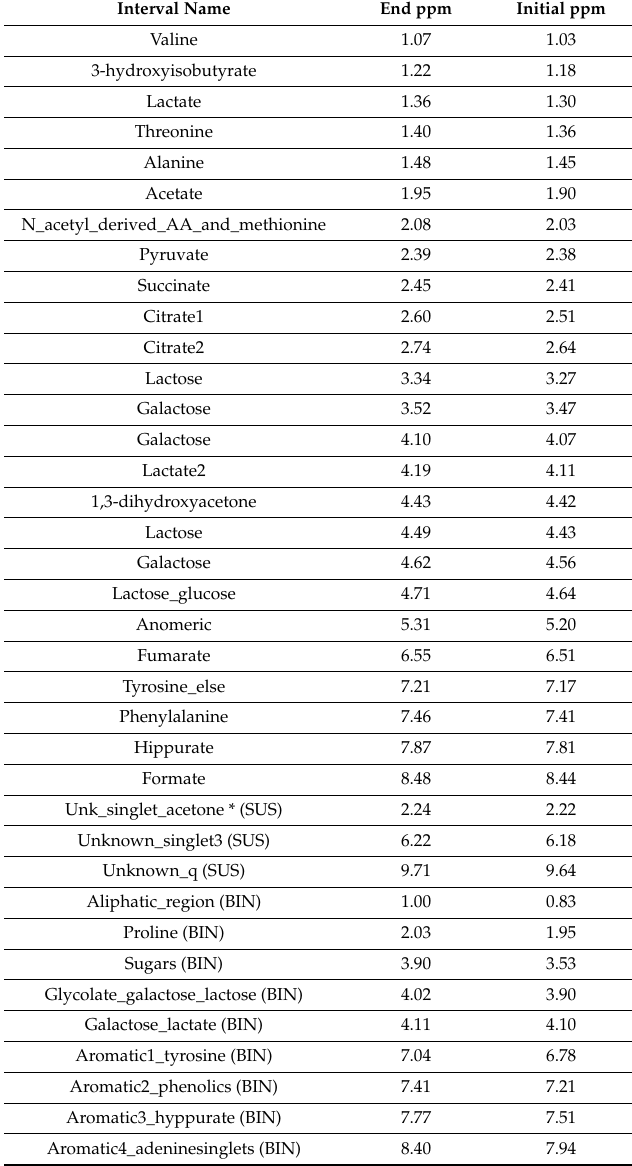
Table A1. Spectral regions identified and relative ppm range. Unassigned signals (SUS) and BINS are also